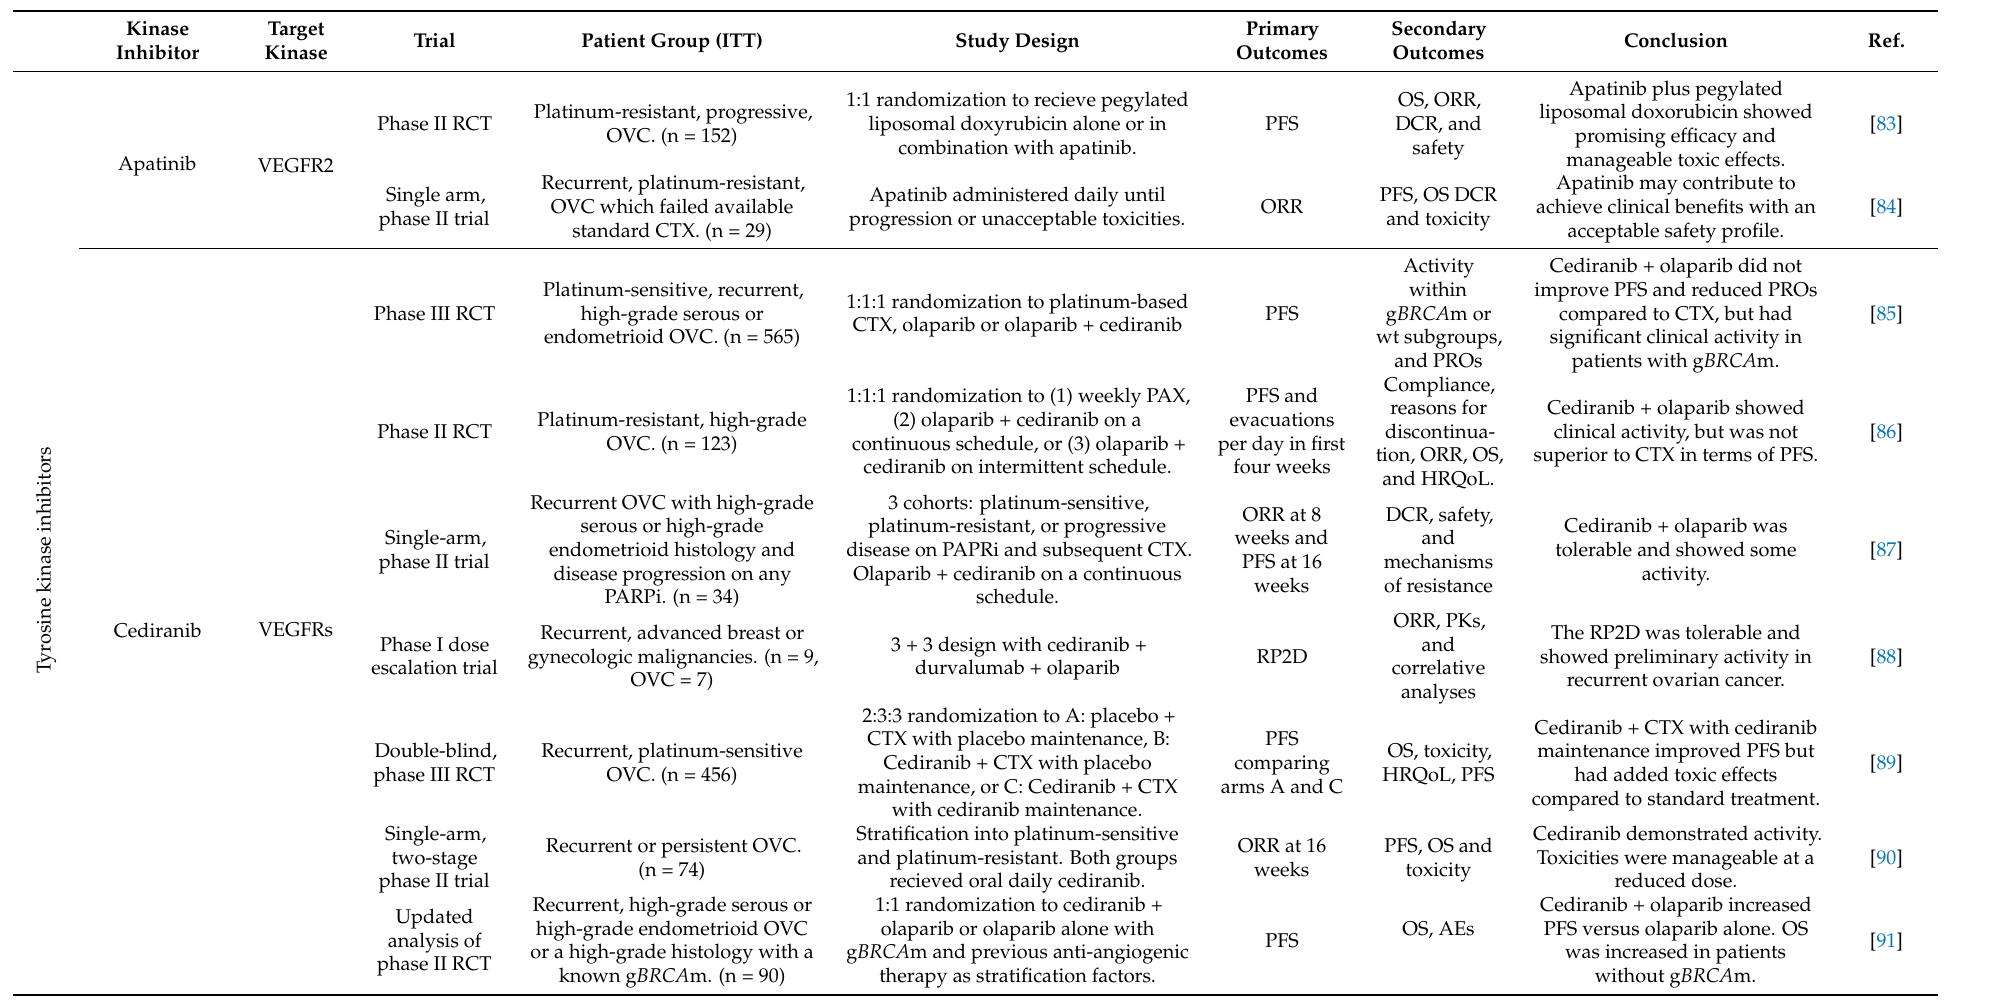
Table 1. Concluded clinical trials with kinase inhibitor treatment of ovarian cancer published since 2015. Kinase